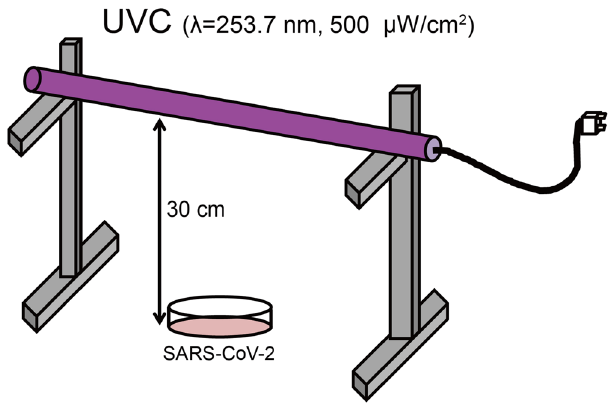
Figure 1. The ultraviolet C (UVC) light irradiation system. A UVC wavelength of 253.7 nm, 500 μW/cm 2 is used. The length and diameter of the light tube are 295 ± 3 mm and 15.5 ± 0.5 mm, respectively. SARS-CoV-2 (5 mL) with a titer of 5 × 10 4 50% tissue culture infective dose (TCID 50 /mL) or (1 mL) with a titer of 1.78 × 10 6 TCID 50 /mL are placed in a 10 cm 2 dish, 30 cm below the UVC light tube, and are continuously and individually irradiated using a UVC lamp for 0, 5, 15 or 30